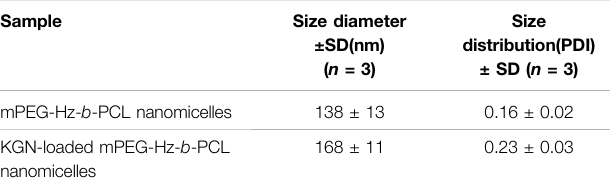
TABLE 1 | Sizes and size distributions of mPEG-Hz- b -PCL nanomicelles and KGN-loaded mPEG-Hz- b -PCL nanomicelles. Sample